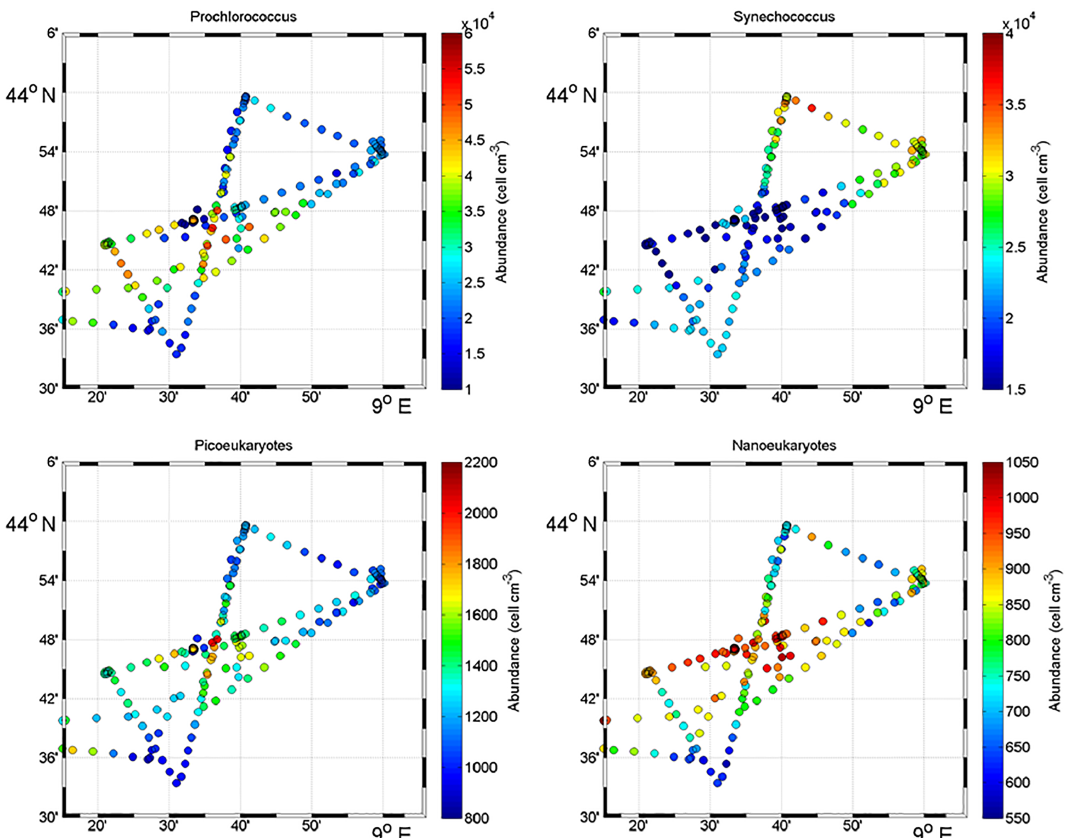
Figure 5. Surface distribution of Prochlorococcus , Synechococcus , picoeukaryote (PicoE + PicoHighFLR + PicoHighFLO) and nanoeukary- ote (NanoE + NanoFLO + NanoHighFLO) abundances (in cellscm − 3